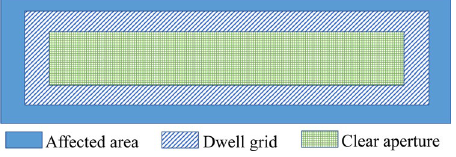
Figure 1. Schematic of the affected area, dwell grid, and clear aperture in an IBF